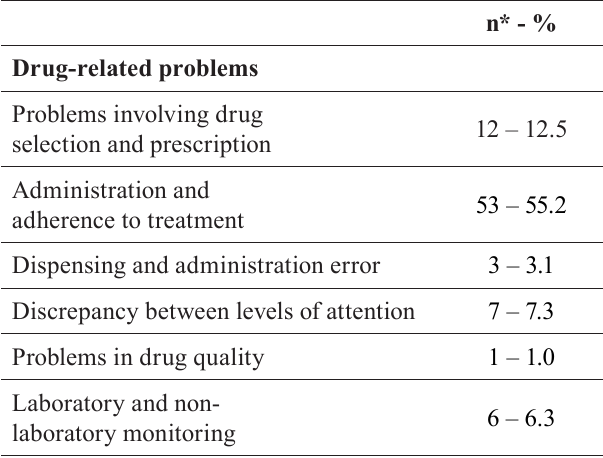
TABLE II - Drug-related problems and pharmaceutical interventions performed in the 12-months